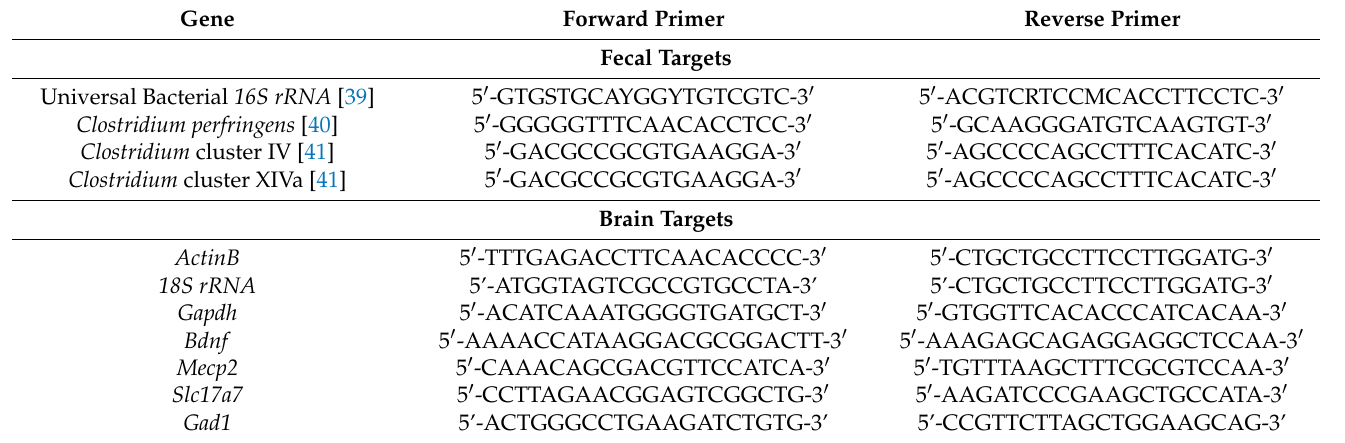
Table 1. List of primer